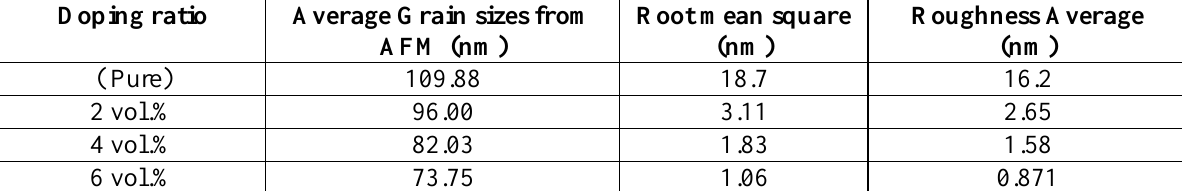
Table 1: The average grain sizes and roughness average for CdO prepared on glass substrates.